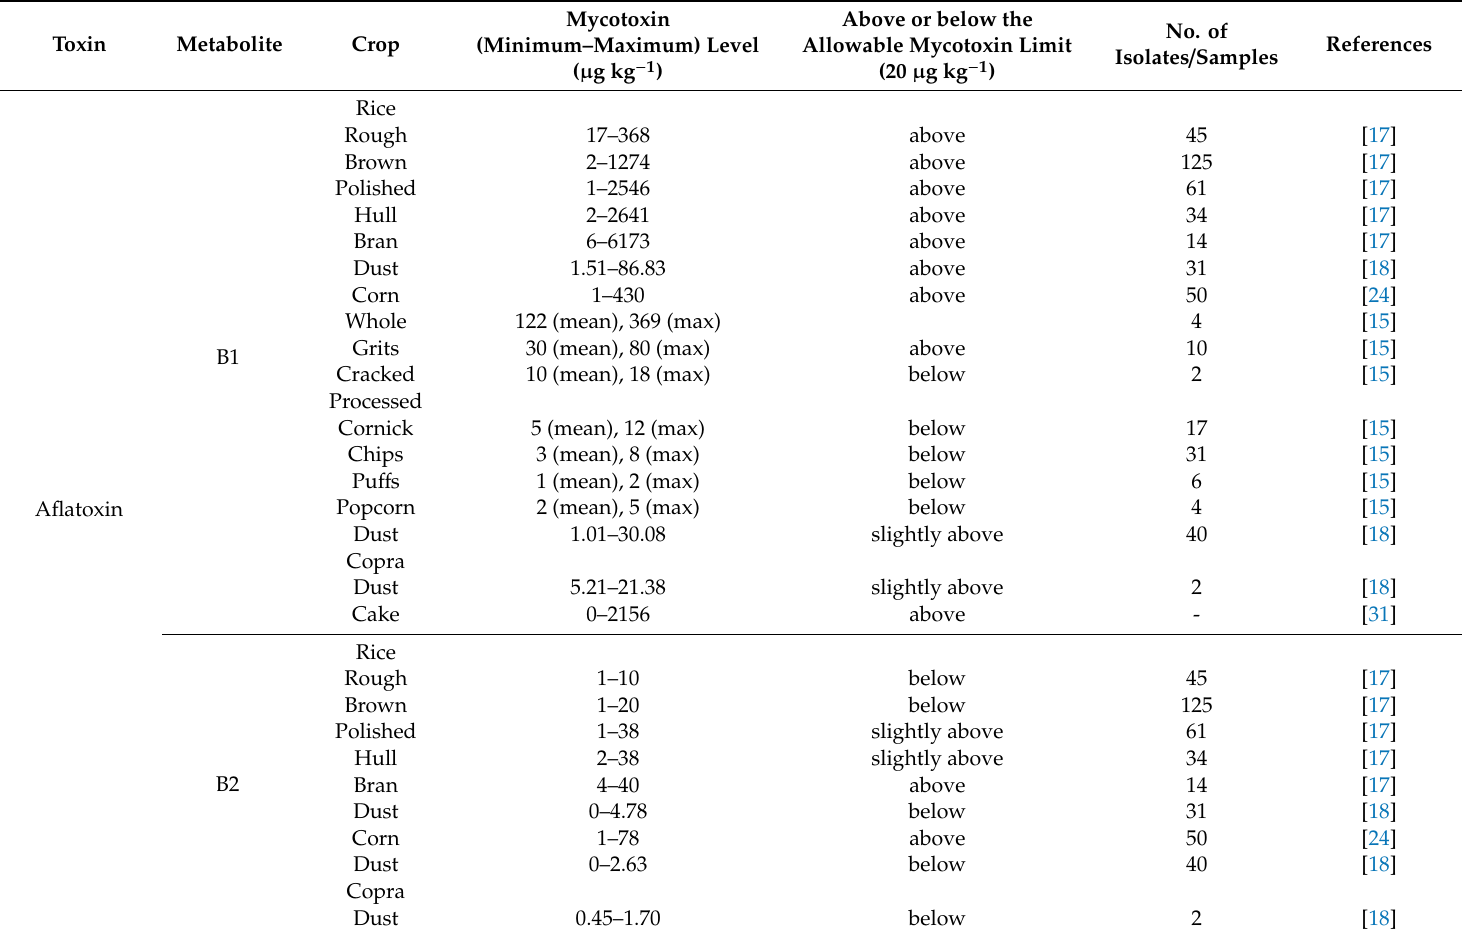
Table 3. Mycotoxin contamination levels in some agricultural crop commodities in the